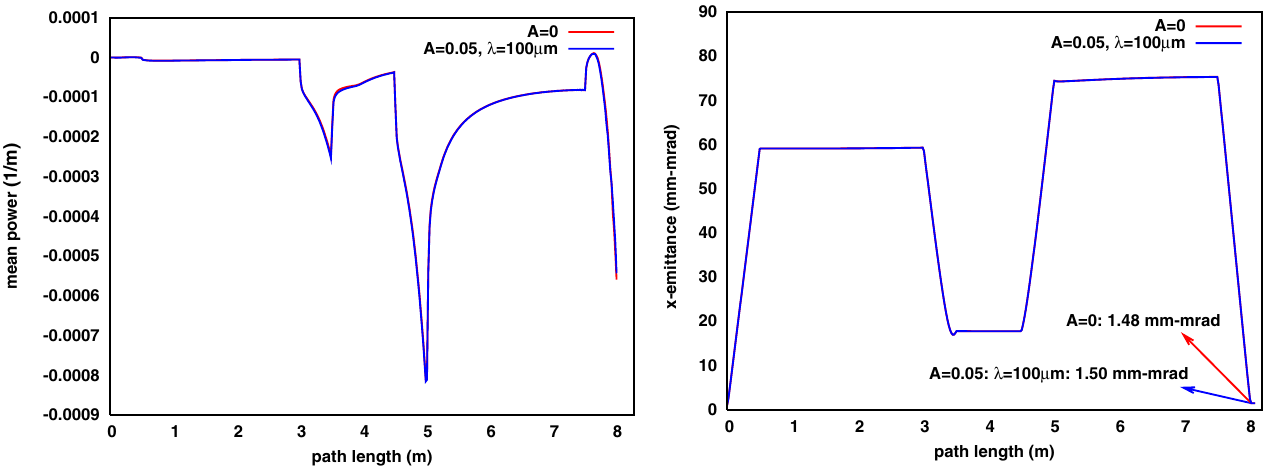
¼ 100 (cid:4) m (blue curve). 0